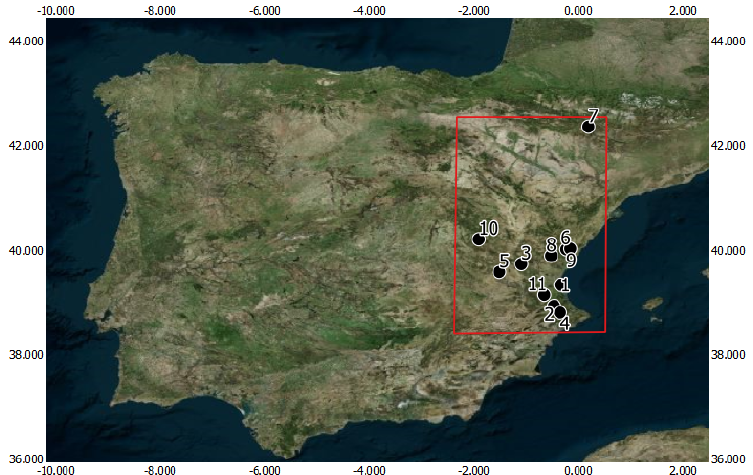
Figure 1. Map of the location of the water bodies used to obtain samples. ( 1 ) Albufera lagoon. ( 2 ) Bellús reservoir. ( 3 ) Benagéber reservoir. ( 4 ) Beniarrés reservoir. ( 5 ) Contreras reservoir. ( 6 ) Maria Cristina reservoir. ( 7 ) Mediano reservoir. ( 8 ) Regajo reservoir. ( 9 ) Sitjar reservoir. ( 10 ) Toba reservoir. ( 11 ) Tous reservoir. Source: IGN and Sentinel-2 cloudless,